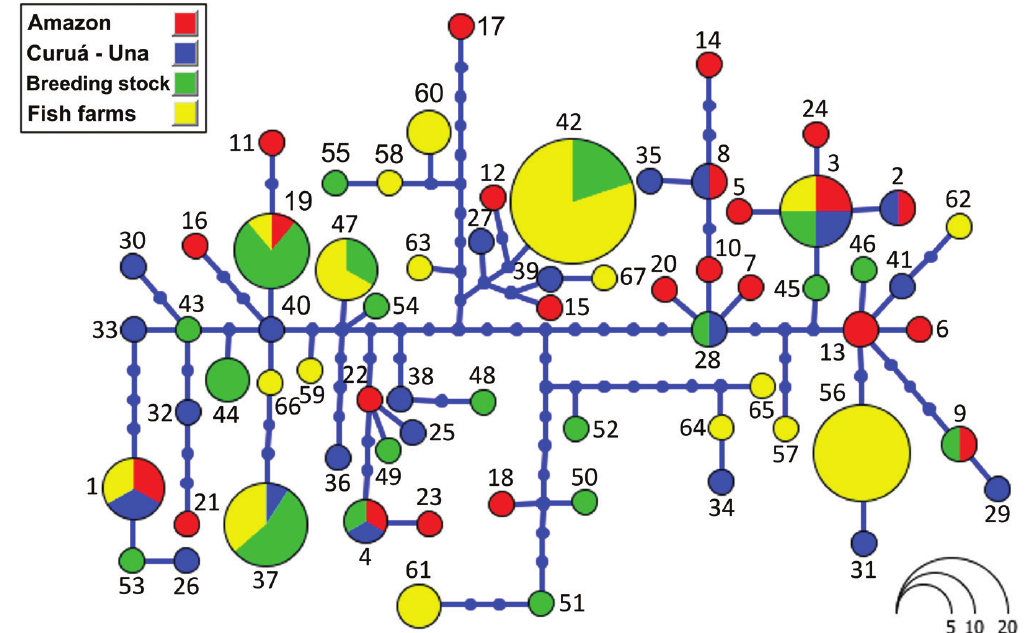
Figure 2 - Haplotype network constructed in the HaploViewer software based on the sequences of the mitochondrial Control Region of specimens from two wild populations, a breeding stock, and local fish farms in central